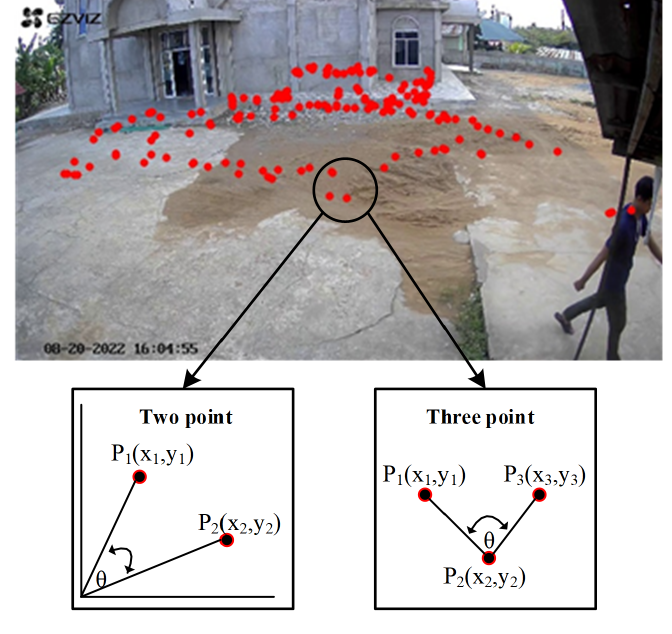
Figure 10. Angular feature extraction